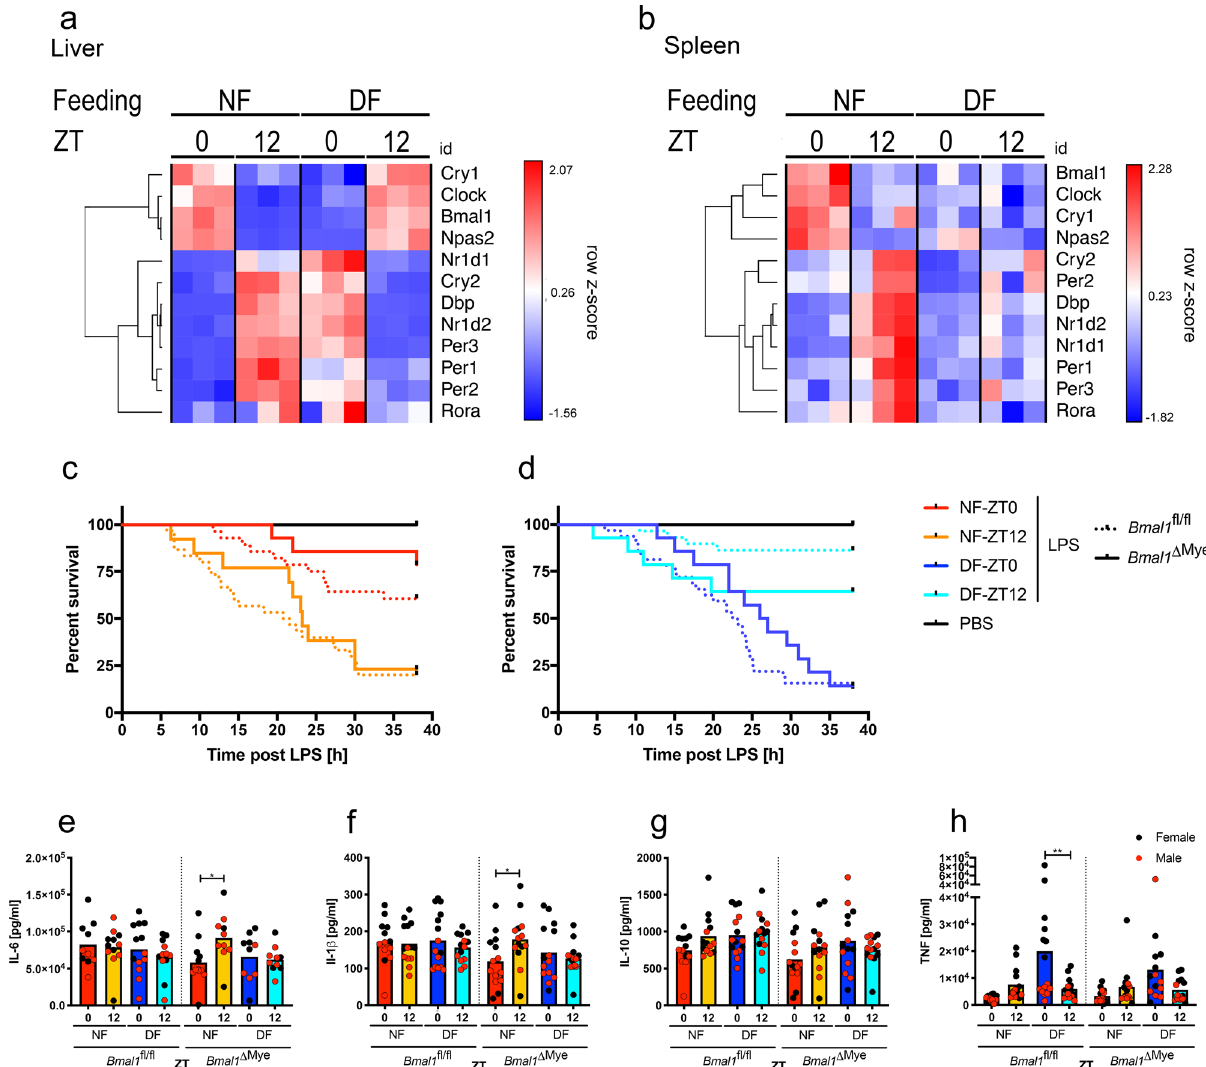
Fig. 3 The myeloid clock is dispensable for feeding time-dependent mortality. a , b Liver ( a ) and spleen ( b ) gene expression pro fi le of selected clock genes measured by NanoString on day 5 of TRF at indicated times in female mice. Unsupervised gene clustering. c , d Morbidity in night-time ( c ) or day- time ( d ) fed myeloid cell speci fi c Bmal1 Δ Mye (solid) (NF ZT0 vs. 12 p = 0.0032, DF ZT 0 vs. 12 ns, ZT0 NF vs. DF p = 0.0005, ZT12 NF vs. DF ns), or control Bmal1 fl / fl (dashed line) mice (NF 0 vs. 12 p = 0.0008, DF 0 vs. 12 p < 0.0001, ZT0 NF vs. DF p < 0.0001, ZT12 NF vs. DF p < 0.0001)